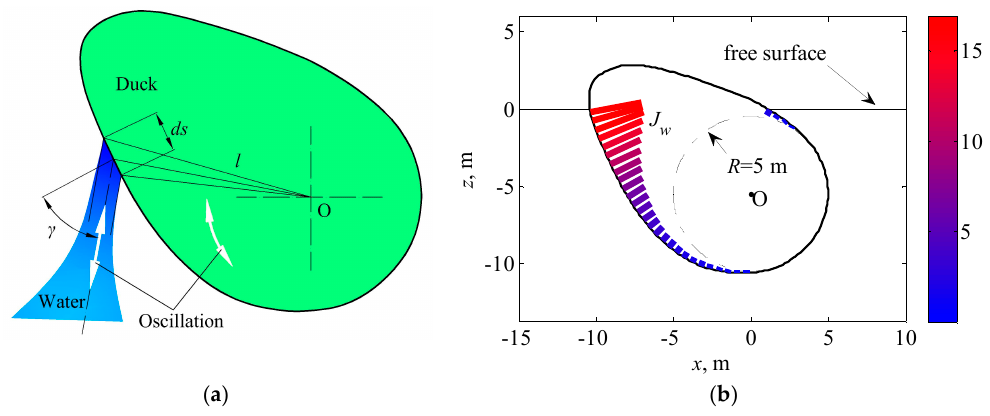
Figure 6. Demonstration of the water inertia: ( a ) the flow pattern of a small piece of water near the wetted Duck surface; and ( b ) distribution of the water inertia along the wetted Duck surface at d = 5.5 m and θ b = 144°.